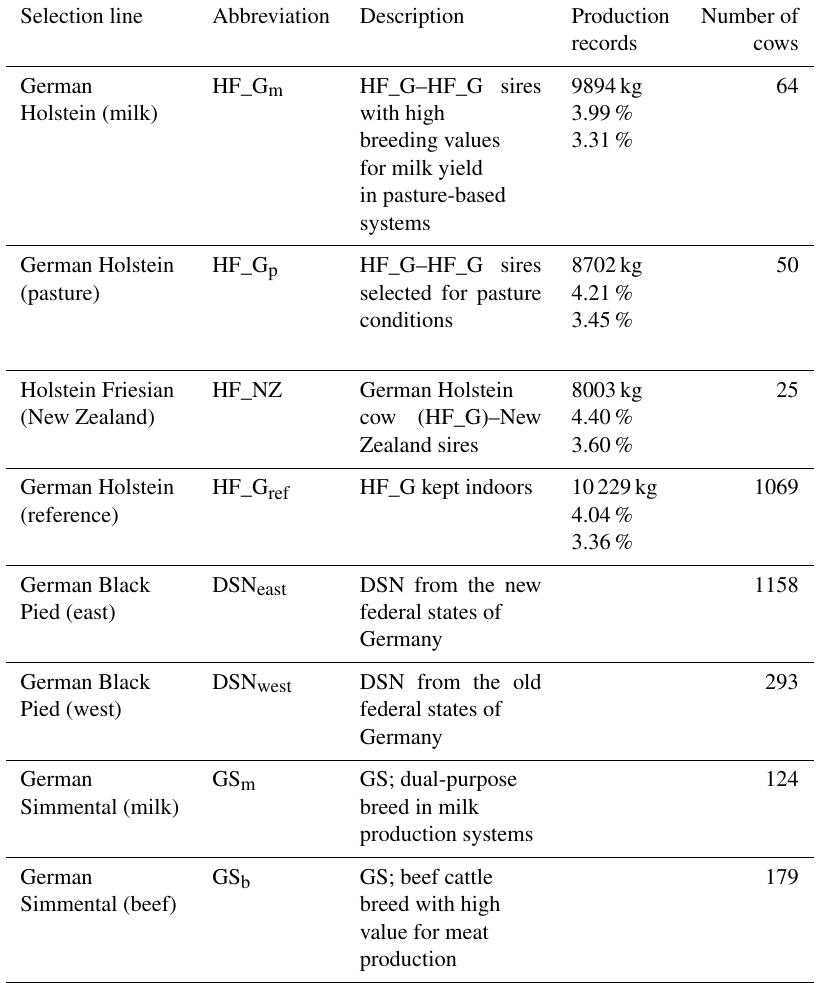
Table 1. Description of selection lines of the Holstein Friesian (HF), German Black Pied (DSN) and German Simmental (GS) breeds and lactation production records for milk yield, fat percentage and protein percentage for the HF